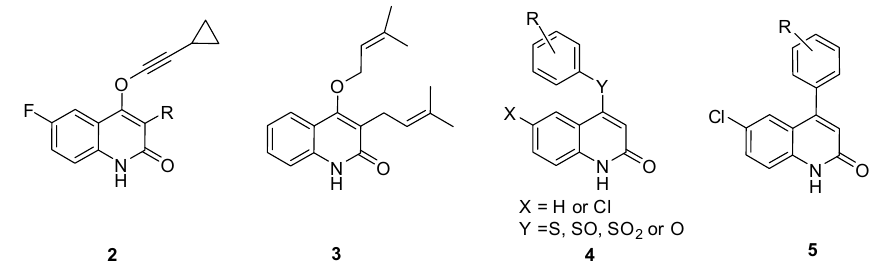
Figure 2. quinolin-2-one NNRTIs and newly designed